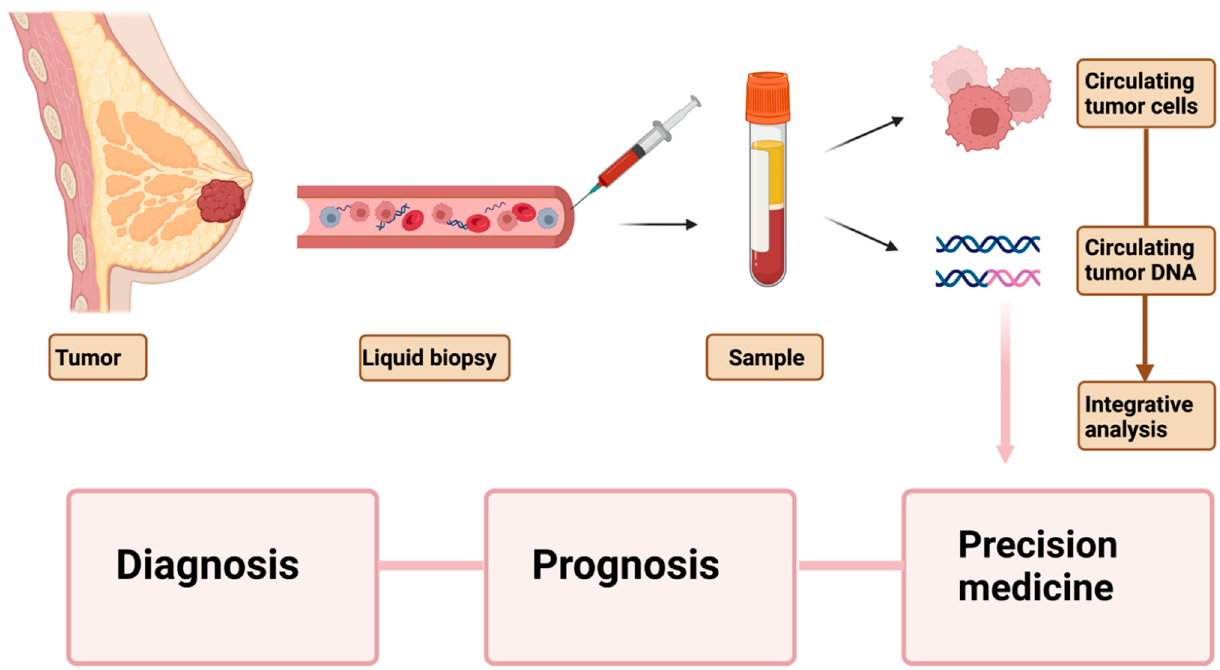
Figure 1. Peripheral blood-based biopsy for breast cancer diagnosis, prognosis, and precision medicine. Circulating blood markers such as CTCs and ctDNA are gaining prominence in cancer diagnosis, therapy monitoring, and development of personalized medicine. However, to bring these liquid biopsy markers into clinical practice, strategies for integrative analyses of these bio-analytes along with existing diagnostic tools need to be developed. Created with BioRender.com.